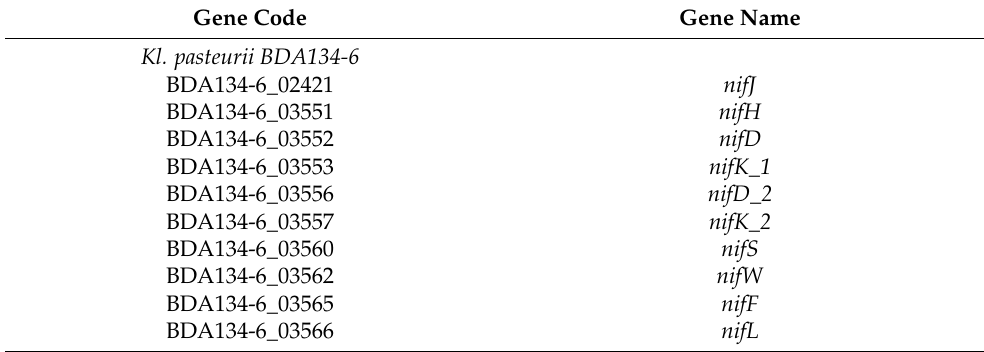
Table 2. Identification of nif gene cluster in the genome of Kl. pasteurii BDA134-6, Ko. pseudosacchari BDA62-3 and P. diazotrophicus